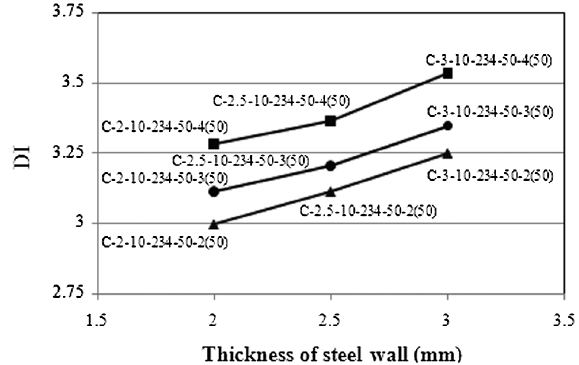
Fig. 14. Effect of steel wall thickness on ductility